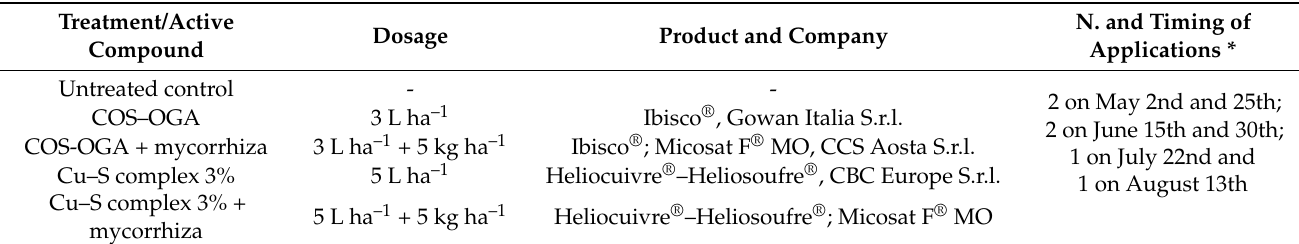
Table 8. Integrated strategies adopted in the application of Cu and S formulation and alternative products (COS-OGA and mycorrhizae) and dates of the grapevine foliar applications for Nero d’Avola and Inzolia cultivars in different